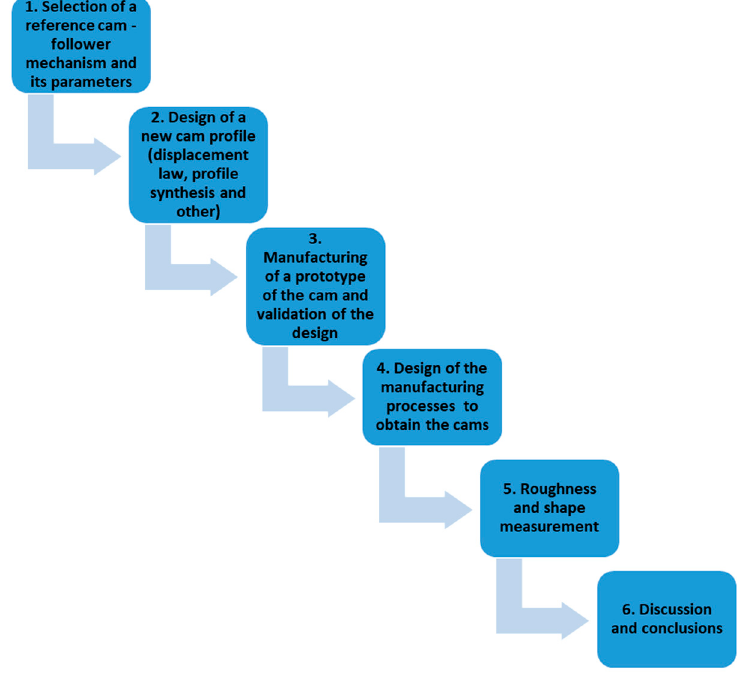
Figure 2. The general methodology of the paper.